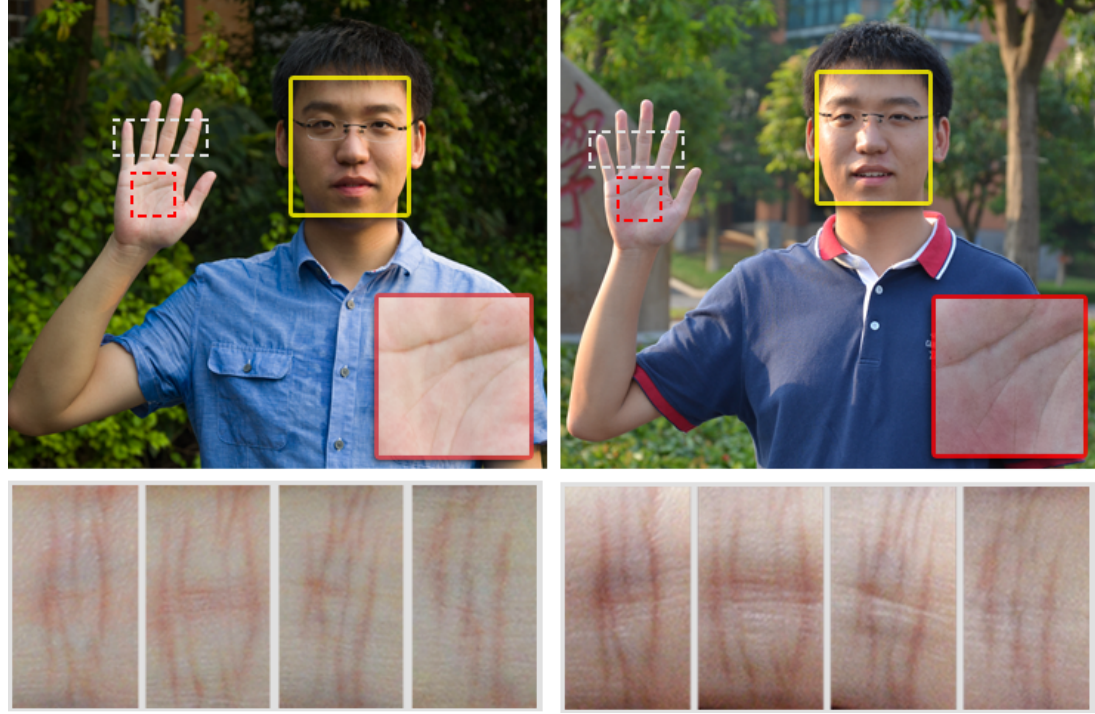
Figure 1. Pictures captured under different environments. The yellow, red and white boxes indicate the face, palm print and inner knuckle print (IKP) (middle nodes) characteristics,